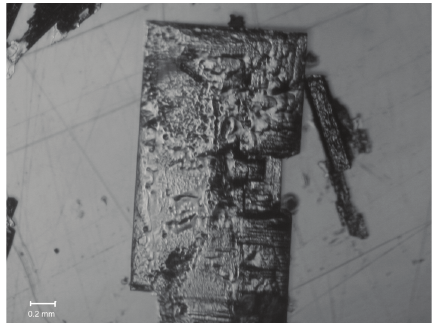
Figure 1: As grown C 60 (FeCp 2 ) 2 single